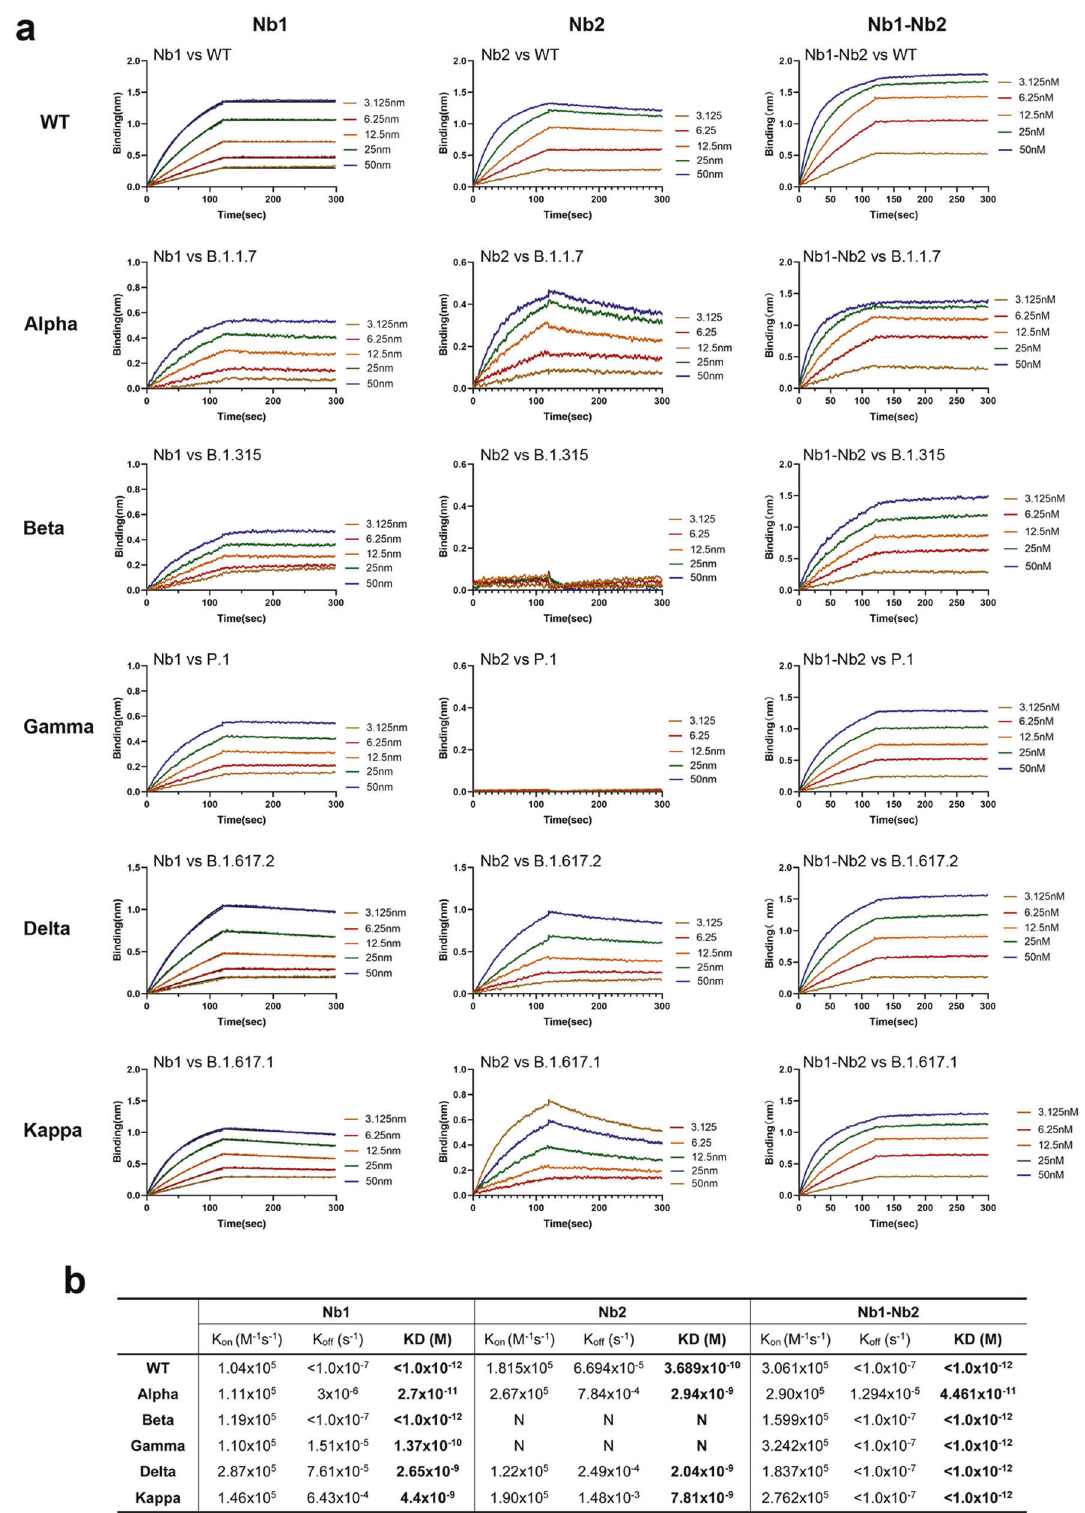
Fig. 2 Binding af fi nity of Nbs against the RBDs from multiple circulating SARS-CoV-2 variants. a Fitted line plot showing the binding kinetic of Nbs with the immobilized receptor-binding domain (RBD) proteins, measured using bio-layer interferometry (BLI). Recombinant RBD proteins were derived from SARS-CoV-2 WT, Alpha, Beta, Gamma, Delta, or Kappa strain. The concentrations of Nb are shown in different colors. b Summary of BLI kinetic and af fi nity measurements. The equilibrium dissociation constant (KD), the association constant (K on ) and the dissociation constant (K off ) are presented. The assays without binding are marked as “ N ”